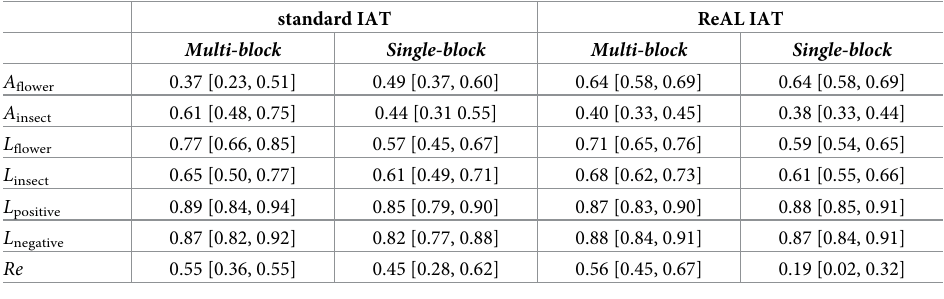
Table 2. Parameter estimates from Replication Experiment